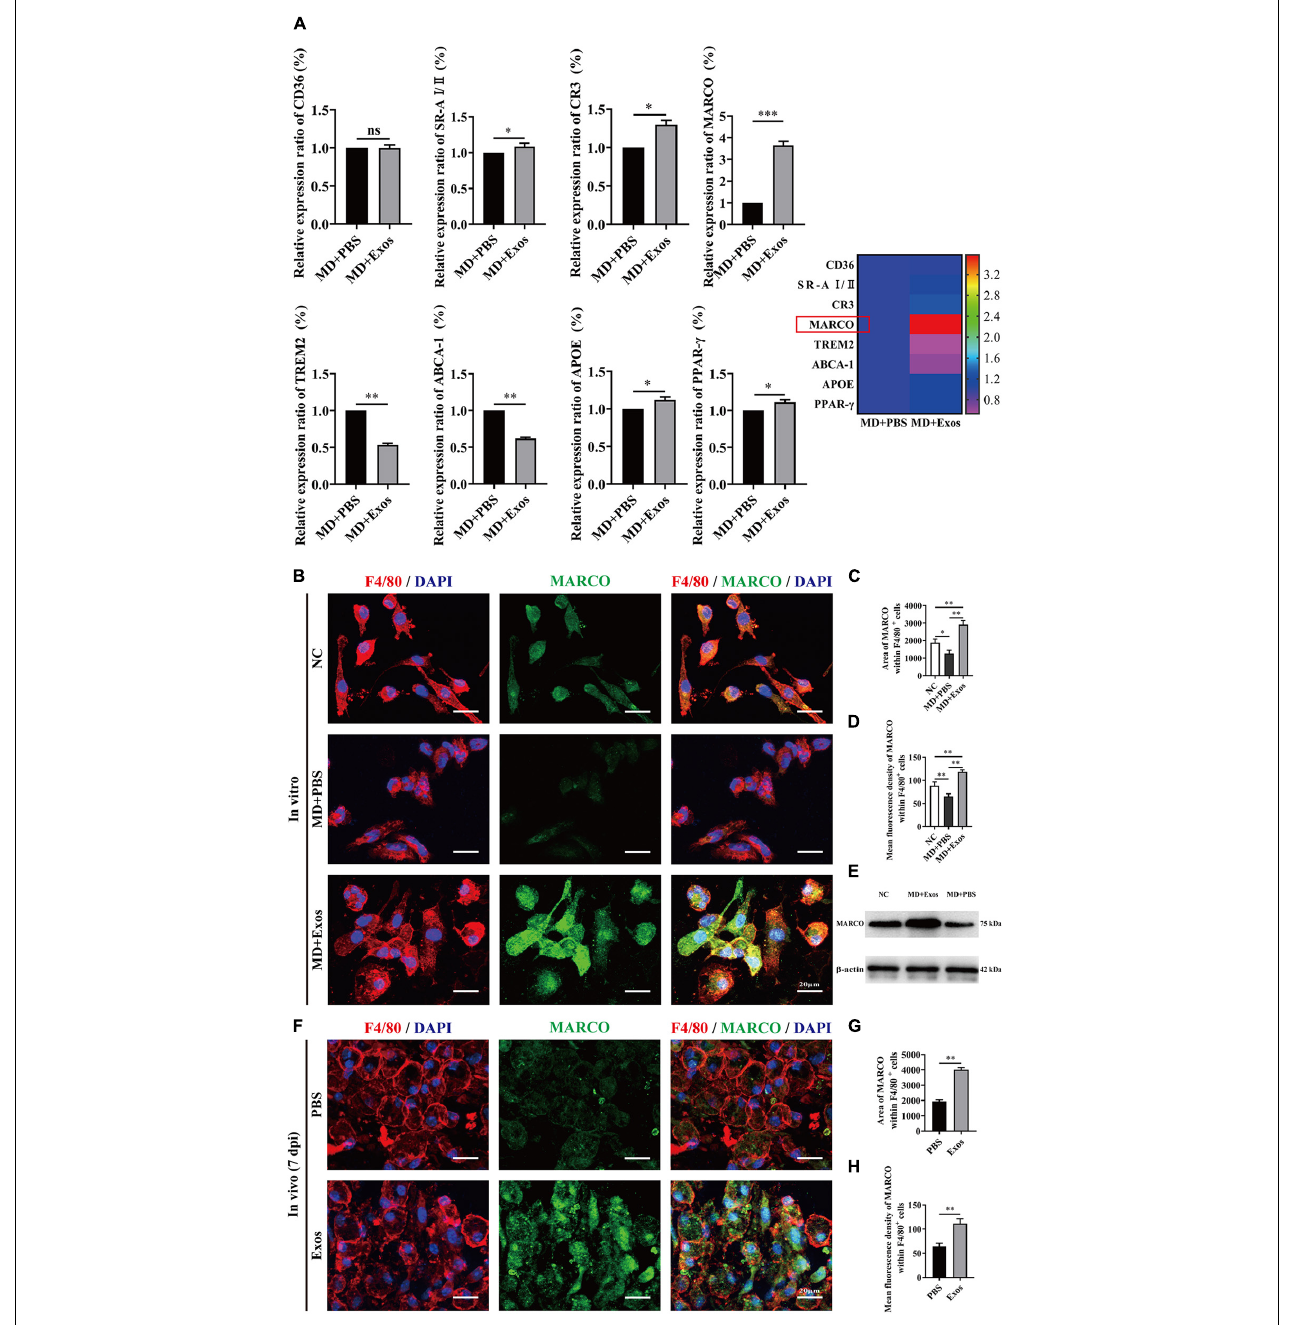
FIGURE 7 | Bone marrow mesenchymal stem cell-derived exosomes (BMSC-Exos) upregulate the expression of macrophage receptor with collagenous structure (MARCO) in macrophages both in vitro and in vivo . (A) The relative gene expression and mapping of genes related to phagocytizing myelin debris of macrophages was detected by qRT-PCR ( n = 3 per group, values are the mean ± SD, ns indicates no significance, ∗ p < 0.05, ∗∗ p < 0.01, ∗∗∗ p < 0.001, two-tailed Student’s t -tests). (B) Representative immunofluorescence images of MARCO expression (MARCO, green) in macrophages (F4/80, red) in the NC, MD + PBS, and MD + Exos groups. Nuclei were counterstained with DAPI (blue). Scale bars = 20 µ m. (C,D) Immunofluorescence semiquantification of the area and mean fluorescence density of MARCO within the F4/80+ macrophages cells ( n = 3 per group, values are the mean ± SD, ∗ p < 0.05, ∗∗ p < 0.01, one-way ANOVA). (E) Western blotting analysis of MARCO expression in the NC, MD + Exos, and MD + PBS groups. (F) Representative immunofluorescence images of MARCO expression (MARCO, green) in macrophages (F4/80, red) in the PBS and Exos groups at 7 days post-spinal cord injury (post-SCI). Nuclei were counterstained with DAPI (blue). Scale bars = 20 µ m. (G,H) Immunofluorescence semiquantification of the area and mean fluorescence density of MARCO within the F4/80+ macrophages cells ( n = 5 per group, values are the mean ± SD, ∗ p < 0.05, ∗∗ p < 0.01, one-way ANOVA). MD, myelin debris; NC, negative control; 7 dpi, 7 days post-SCI; PBS, phosphate-buffered saline.